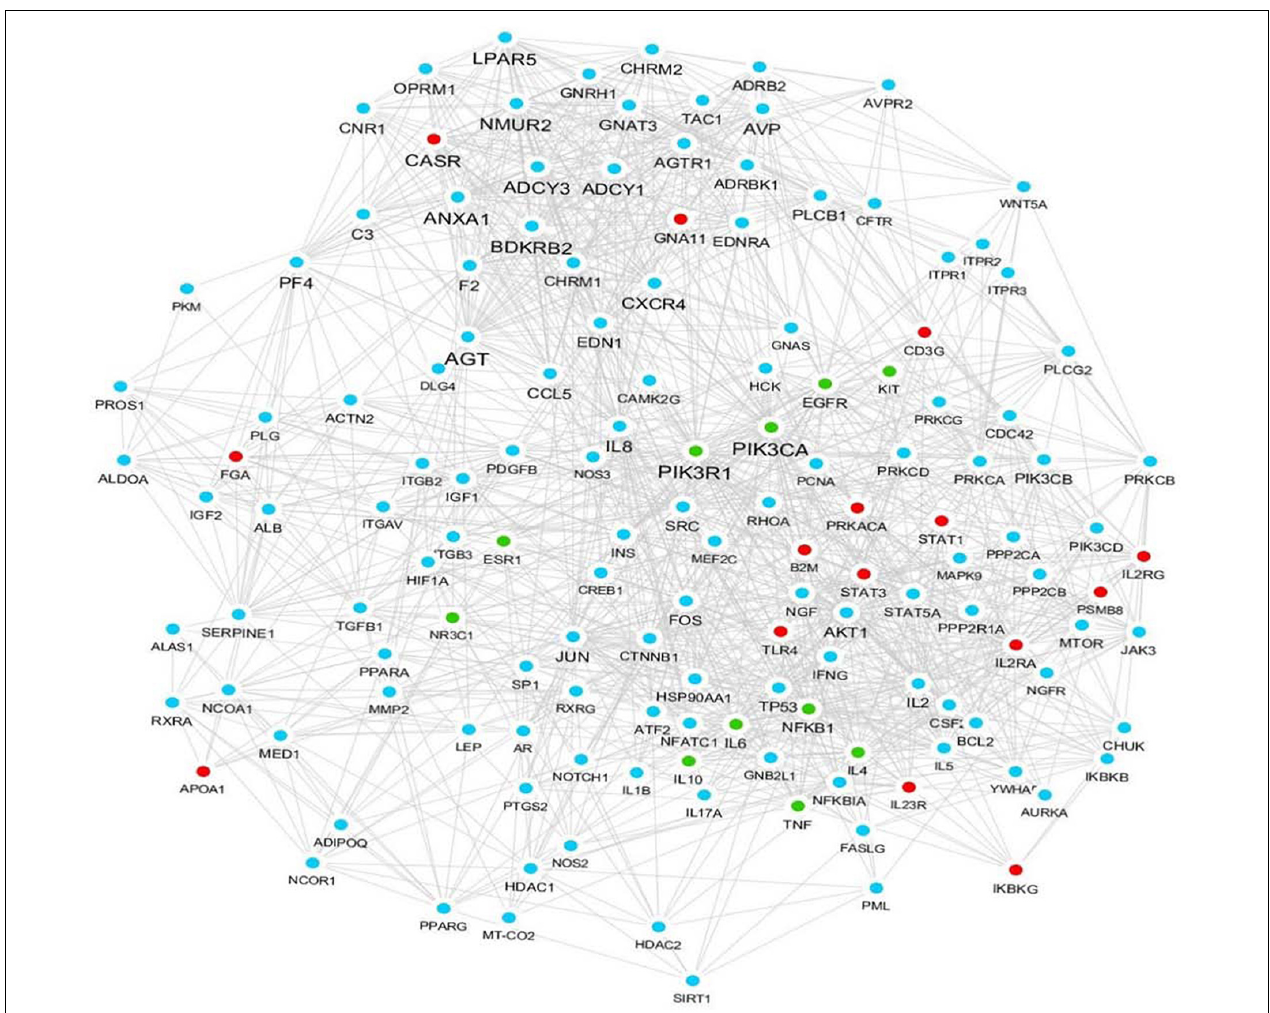
FIGURE 2 | QP ingredient-target-pathway/chronic dermatitis association network. Red nodes correspond to the predicted key targets of chronic dermatitis, such as TLR4, STAT1, STAT3, PRKACA, PSMB8, IL2RG, CD3G, etc. Blue nodes correspond to the key targets of QP ointment, such as IL-8, CXCR4, JUN, IL-1 β , IL-17A, etc., Green nodes represent the key targets associate to both QP and chronic dermatitis, such as IL-4, IL-6, IL-10, TNF, NF κ B1, PIK3R3, PIK3CA, EGFR, KIT, ESR1, NR3C1, etc.